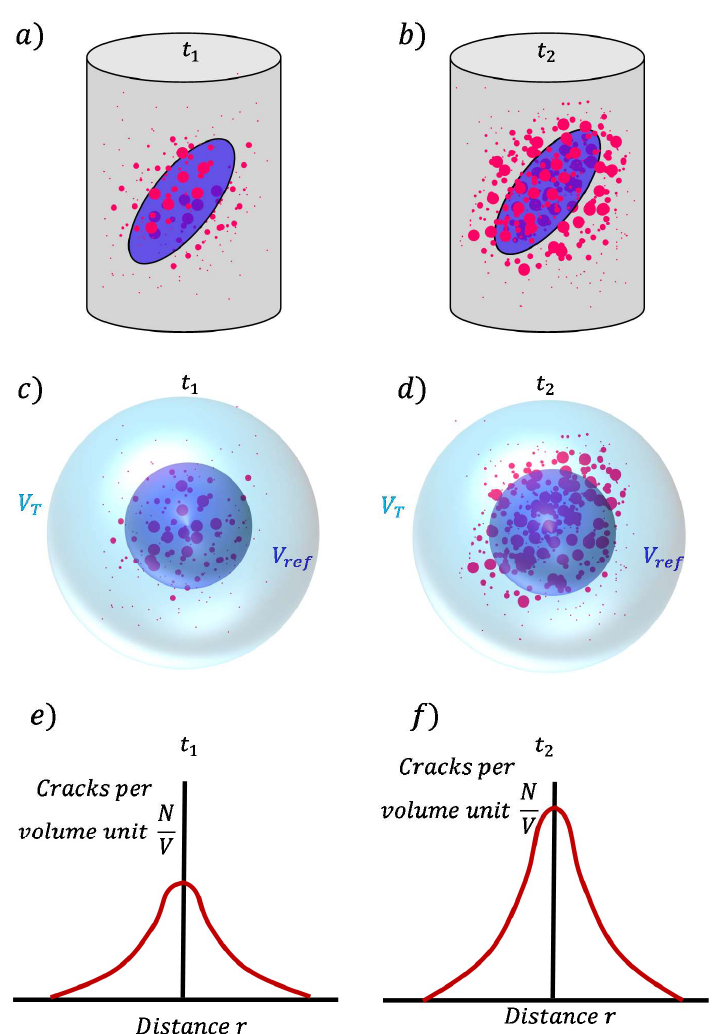
Figure 1. Schematic representation of crack clustering based on results from [11–13]. ( a ) Rock sample’s reaction to triaxial load for two different times. The magenta points represent cracks generated due to the load, and the blue patch represents the impending macroscopic fault. ( b ) The same physical properties in time t 2 where the load increases. ( c , d ) represent the amount of crack generated by volume unit. The reference volume is shown as a blue sphere which encloses more cracks than the light blue one does. ( e , f ) shows the number of cracks per volume area depending on the distance from the center of the reference’s spheres. It is clear that the number of cracks per volume units decreases with distance. Note that the spatial localization increases for time t 2 in ( f ). Experiments in dry or water-saturated rock samples show the growth of the volume of cracks in very reduced areas, before the main failure when samples are triaxially loaded